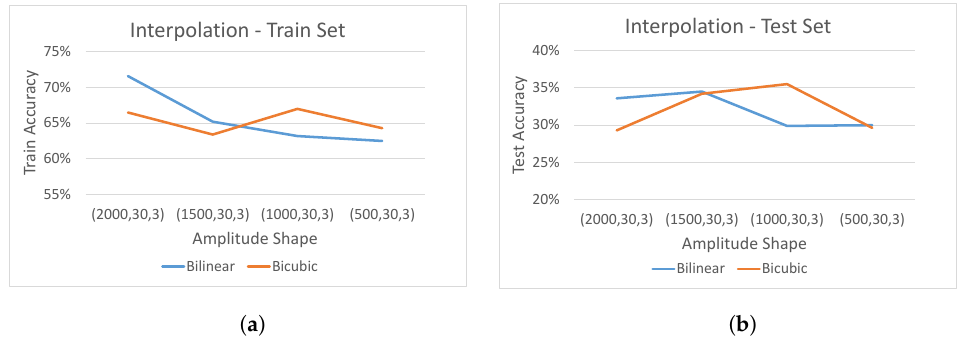
Figure 11. Effect of interpolation with varying input size N . ( a ) Model train accuracy. ( b ) Model test accuracy.